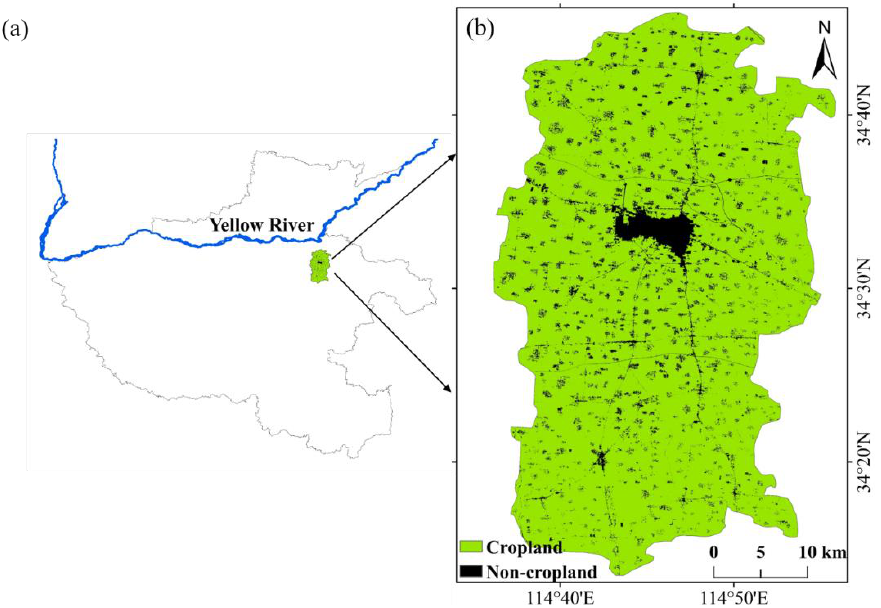
Figure 1. ( a ) Location of Qi County, Henan Province. ( b ) Spatial pattern of the cropland.